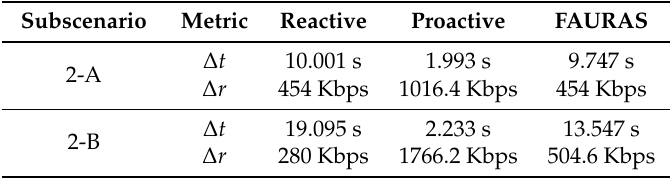
Table 8. Adaptation delay and bitrate degradation amplitude of the client a 1 when using proxy-based methods in scenario #2.